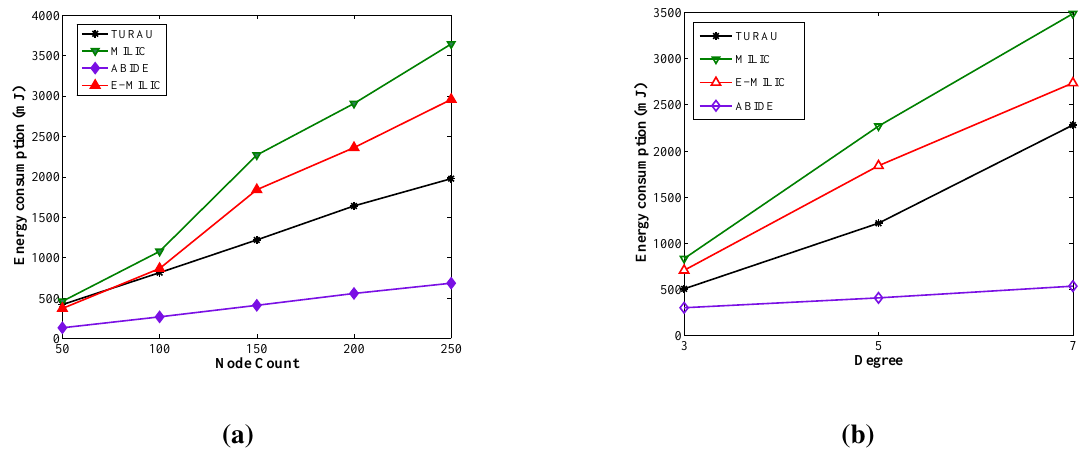
Figure 17. Comparisons between algorithms in terms of energy consumption. ( a ) Energy consumption against node count; ( b ) energy consumption against